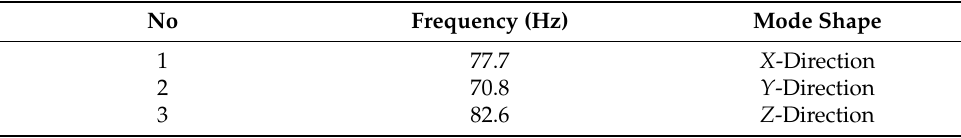
Figure 9. First three-order natural frequencies of combination. Table 4. Modal analysis results of the